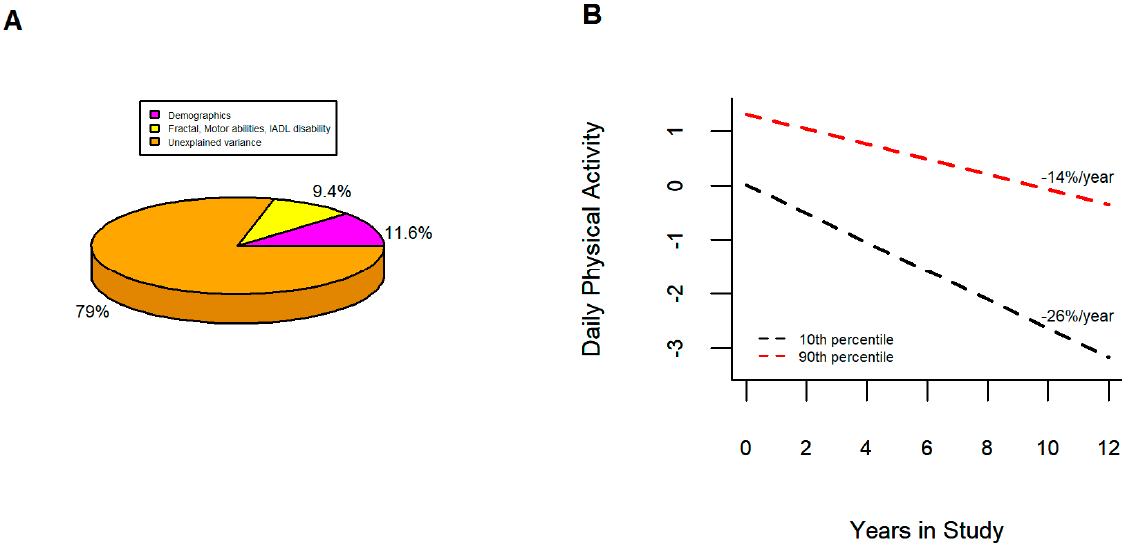
Figure 3. Trajectories of Total Daily Physical Activity in Adults with Low and High Levels of Key Clinical Covariates. ( A ) shows that demographic and three key covariates explained only about 20% of declining total daily physical activity. ( B ) illustrates model derived trajectories of two average participants, female 81 years old with 15 years of education, with low (black) versus high (red) function of key non-demographic covariates associated with the rate of change of total daily physical activity (10th vs. 90th percentile for continuous measures and high IADL disability score versus no disability. Both individuals showed declining daily physical activity, but the rate of decline was about twice as fast in the women with poor baseline function of key clinical covariates compared to the women with good baseline